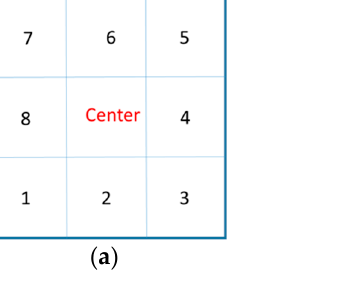
Figure 1. Illustrations of pixel binary format neighborhood connections: ( a ) The ordering of 8 bit; ( b ) the center cell with N = 88 neighborhood index; ( c ) the center cell with N = 93 neighborhood index.